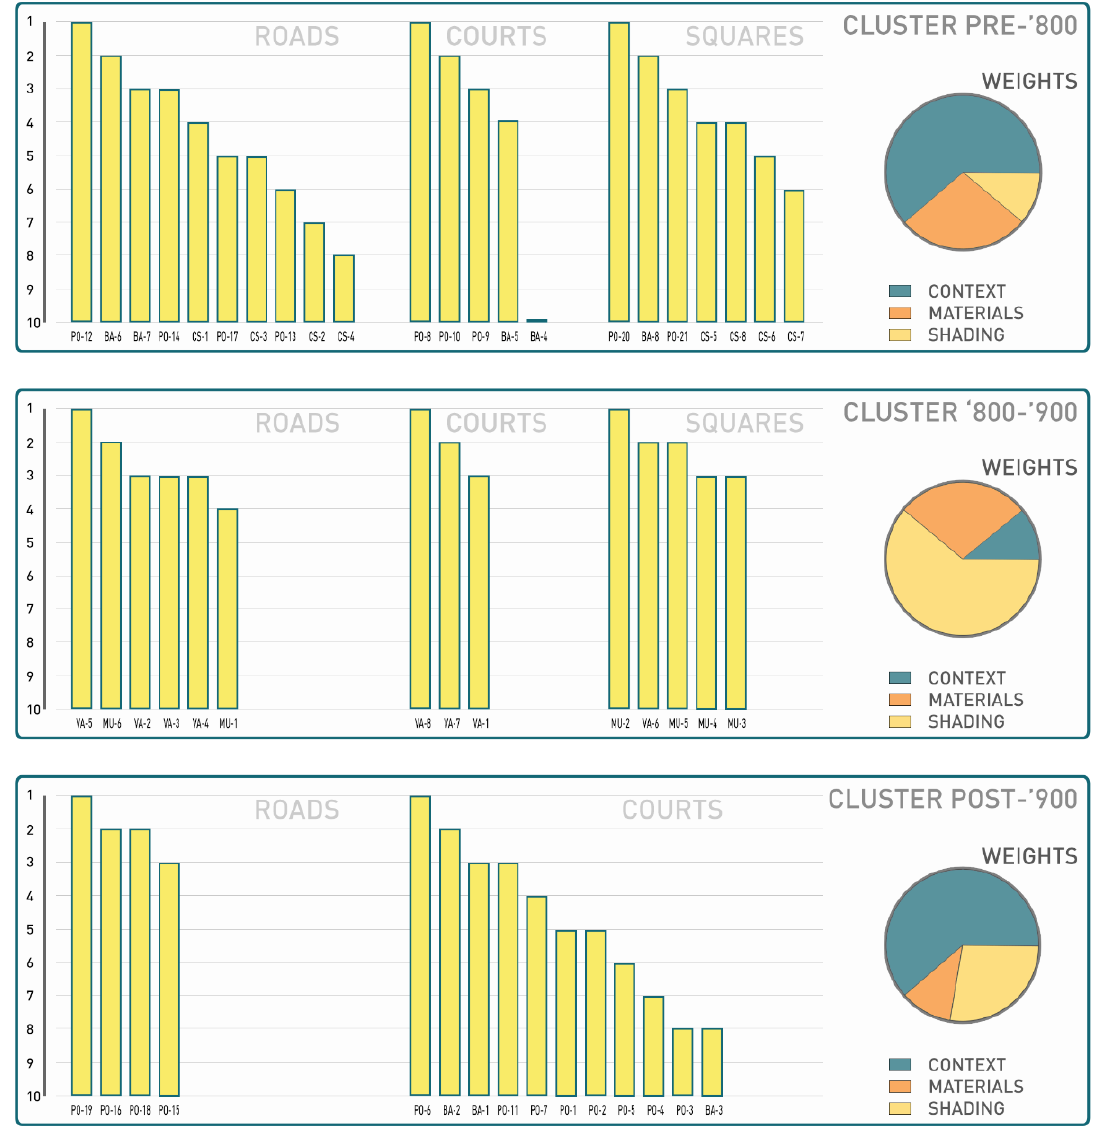
Figure 8. Results of multi-criteria analysis with the same weighting to the three criteria.